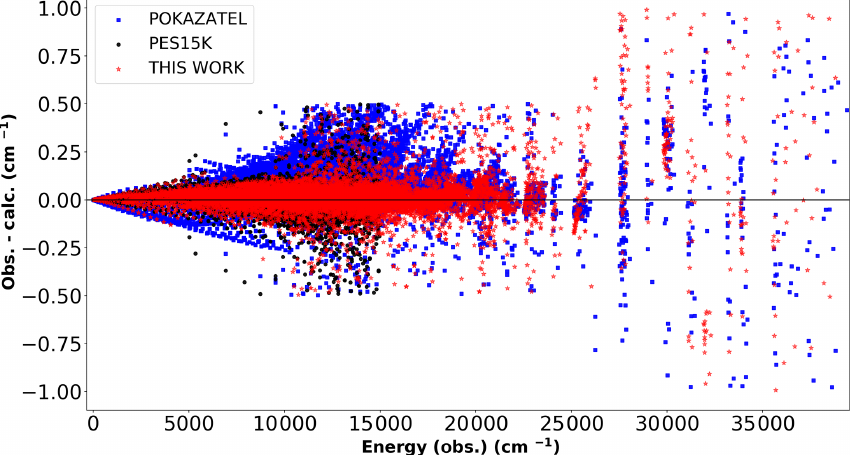
Figure 2. Calculated energy levels obtained from the POKAZATEL (Polyansky et al., 2018) surface, PES15K (Mizus et al., 2018) surface and this work compared to those in the MARVEL database (Furtenbacher et al.,